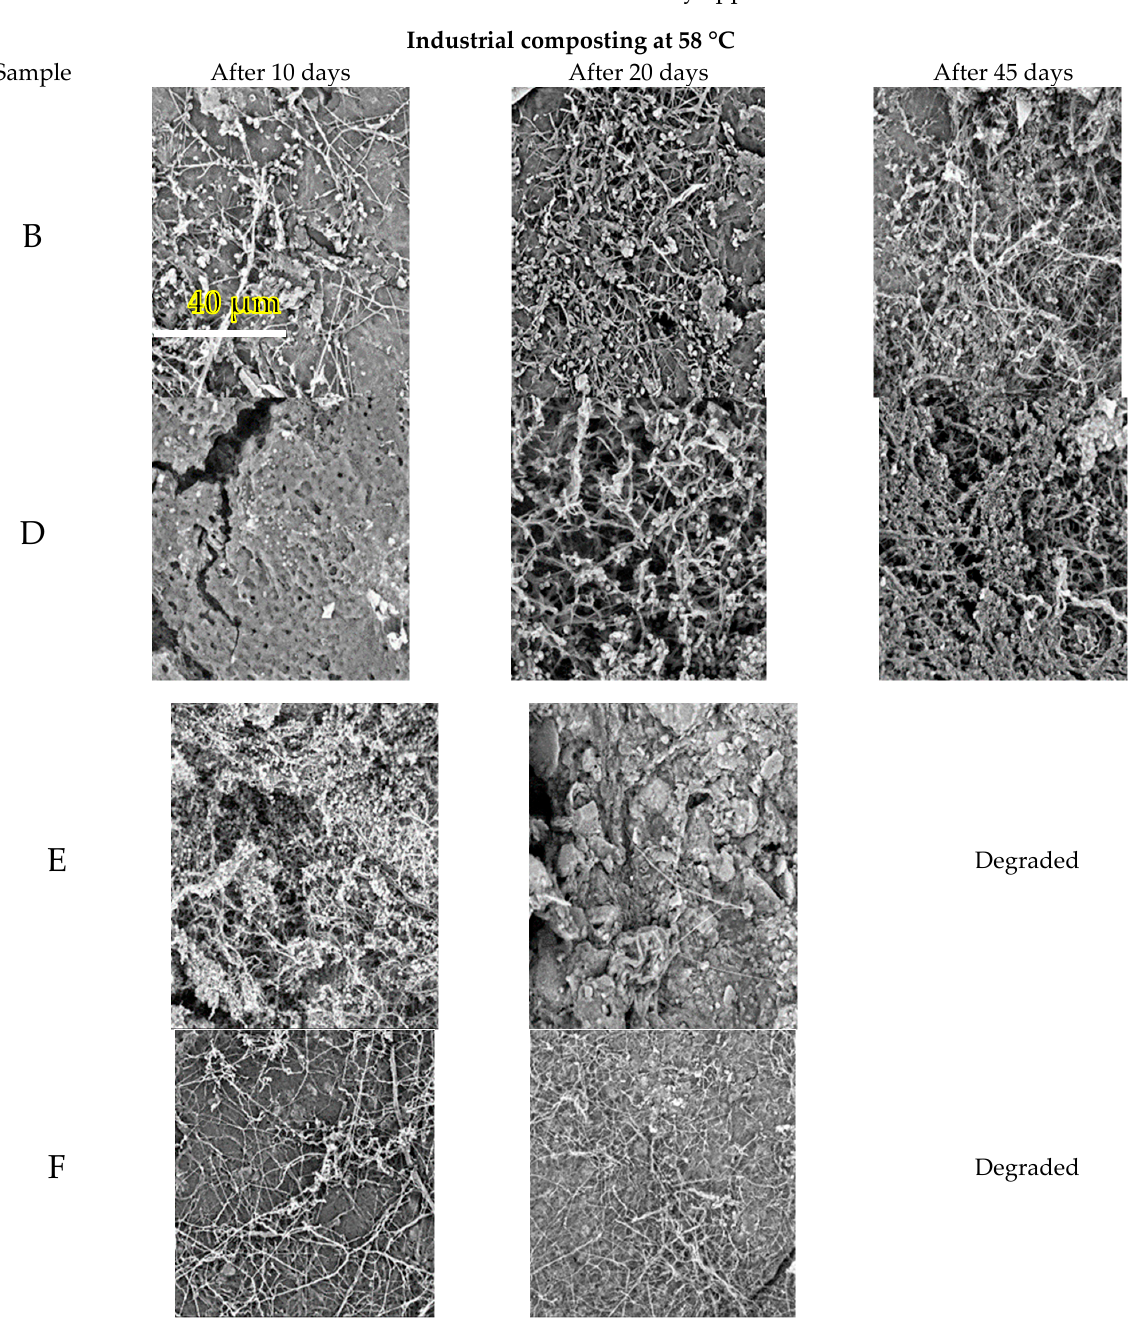
Figure 3. Scanning electron microscopy survey of the sample surface during the biodegradation test at 58 ◦ C (industrial composting condition). Magnification of 5000 × . Specifications according to Table 2 (B—500 mL cup, D—sheet for thermoforming, E—blown film and F—blown film with